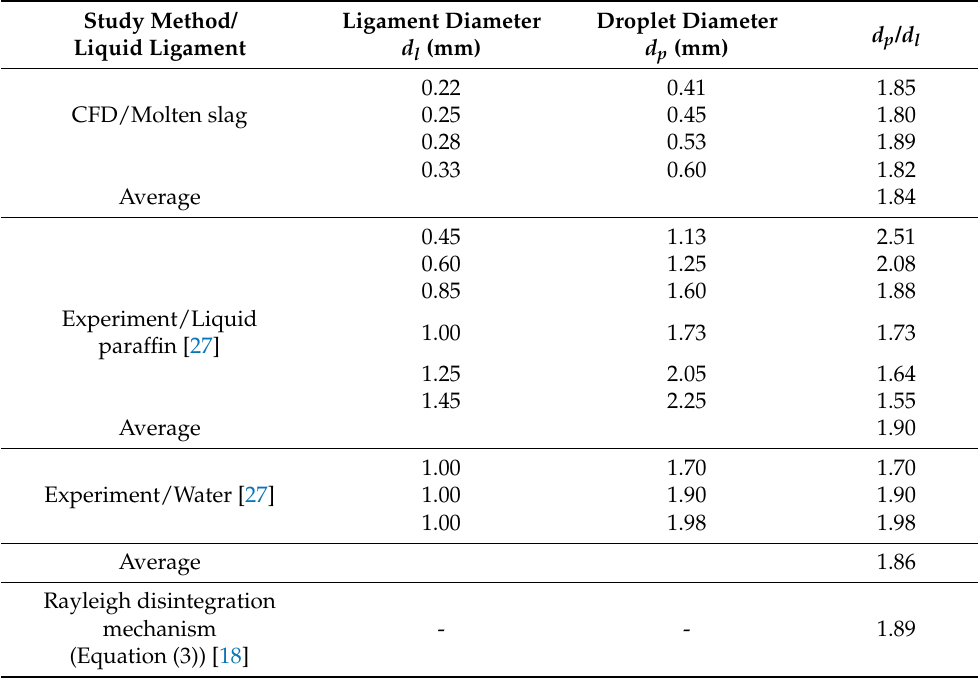
Table 3. Droplet diameter and ligament diameter as well as their ratio for different liquid ligaments’ breakup. Study Method/ Liquid